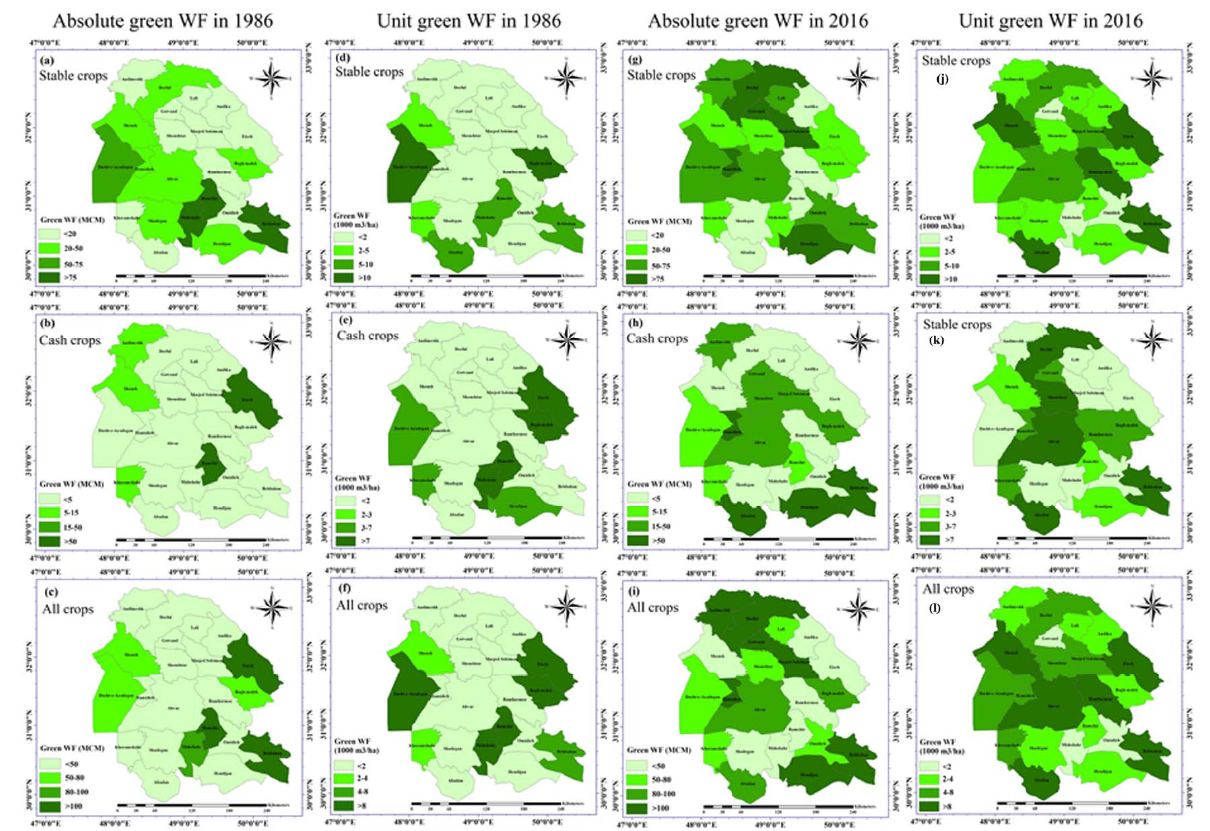
Figure 8. Spatial variation of total (m 3 y − 1 ) ( a – c , g – i ) and unit (10 3 m 3 ha − 1 ) ( d – f , j – l ) green WF related to staple/cash crop production in the Khuzestan province in 1986 and 2016.